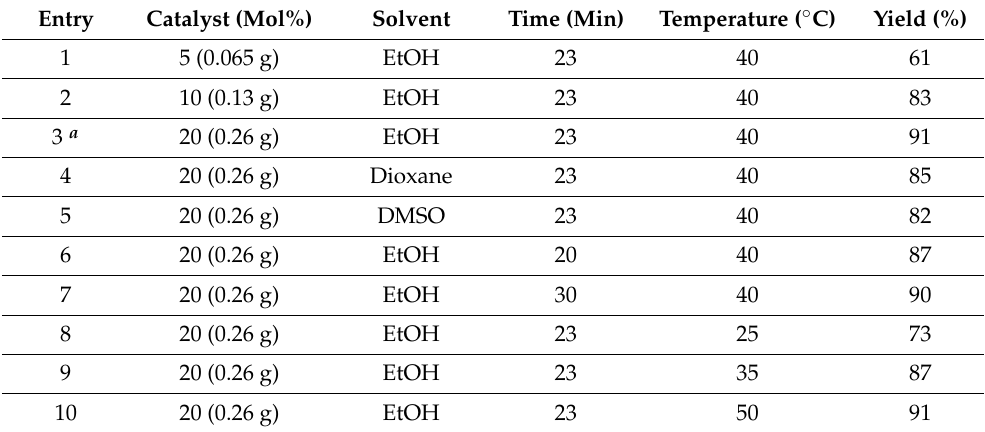
Table 2. Optimization of the reaction conditions (catalyst loading, solvent, reaction time, and temperature) for the prepared component 8a .